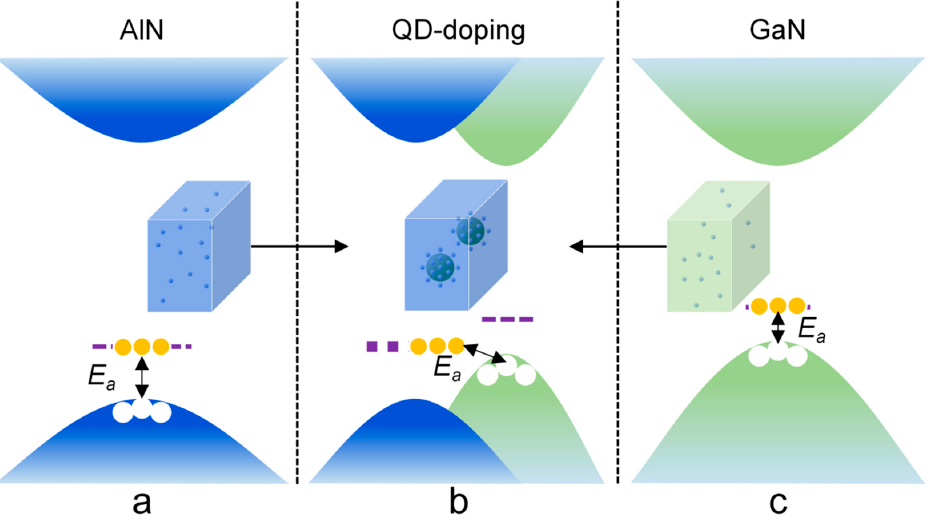
Figure 10. The VBM modulation mode to lower the acceptor E a . Acceptors are randomly doped in ( a ) AlN and ( c ) GaN. Both have high E a in this condition. ( b ) GaN QDs are embedded in the AlN matrix and acceptors are doped in the AlN matrix and concentrate near the interface [ Error! Refer- ence source not found. ].